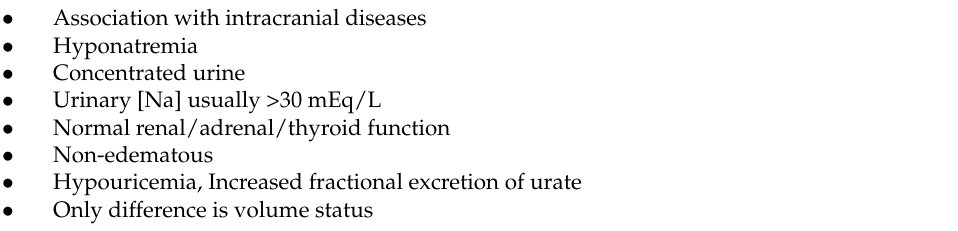
Table 1. Clinical and laboratory findings common to SIADH and